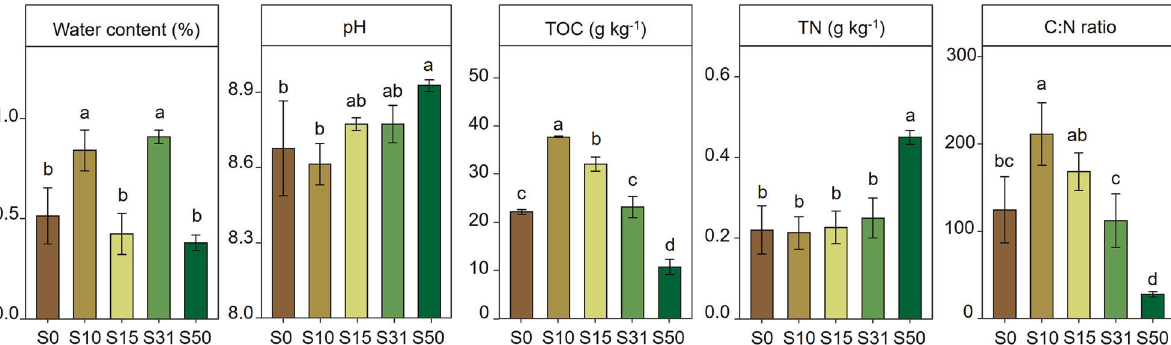
Fig. 2 Soil physicochemical properties in the glacier foreland of Laohugou Glacier No. 12. The numbers in the fi ve sampling sites represent the retreat years (S0, S10, S15, S31, and S50). Different letters indicate signi fi cant differences among sites ( p <